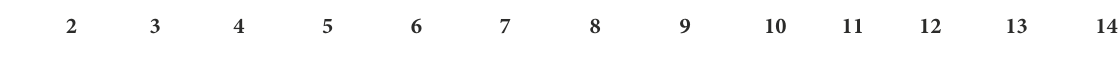
TABLE 2 Descriptive statistics Study 2 (scale, mean, standard deviation, Cronbach’s alpha, and Pearson